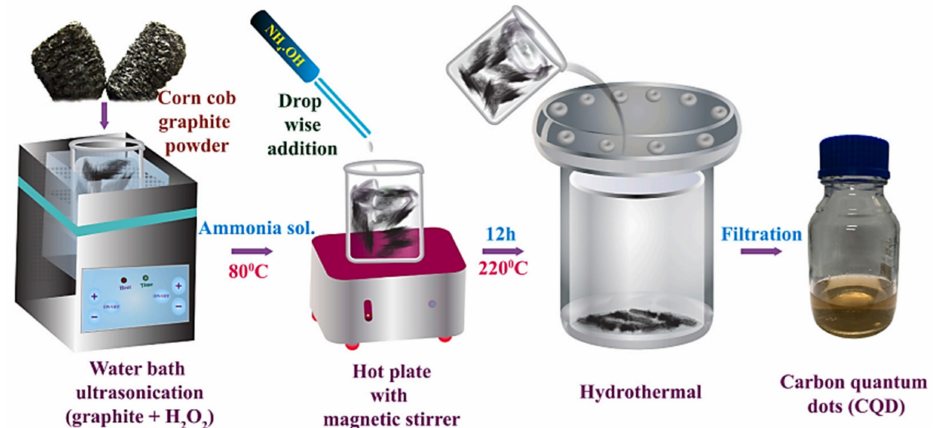
Figure 2. Preparation process of corn cob-derived CQD